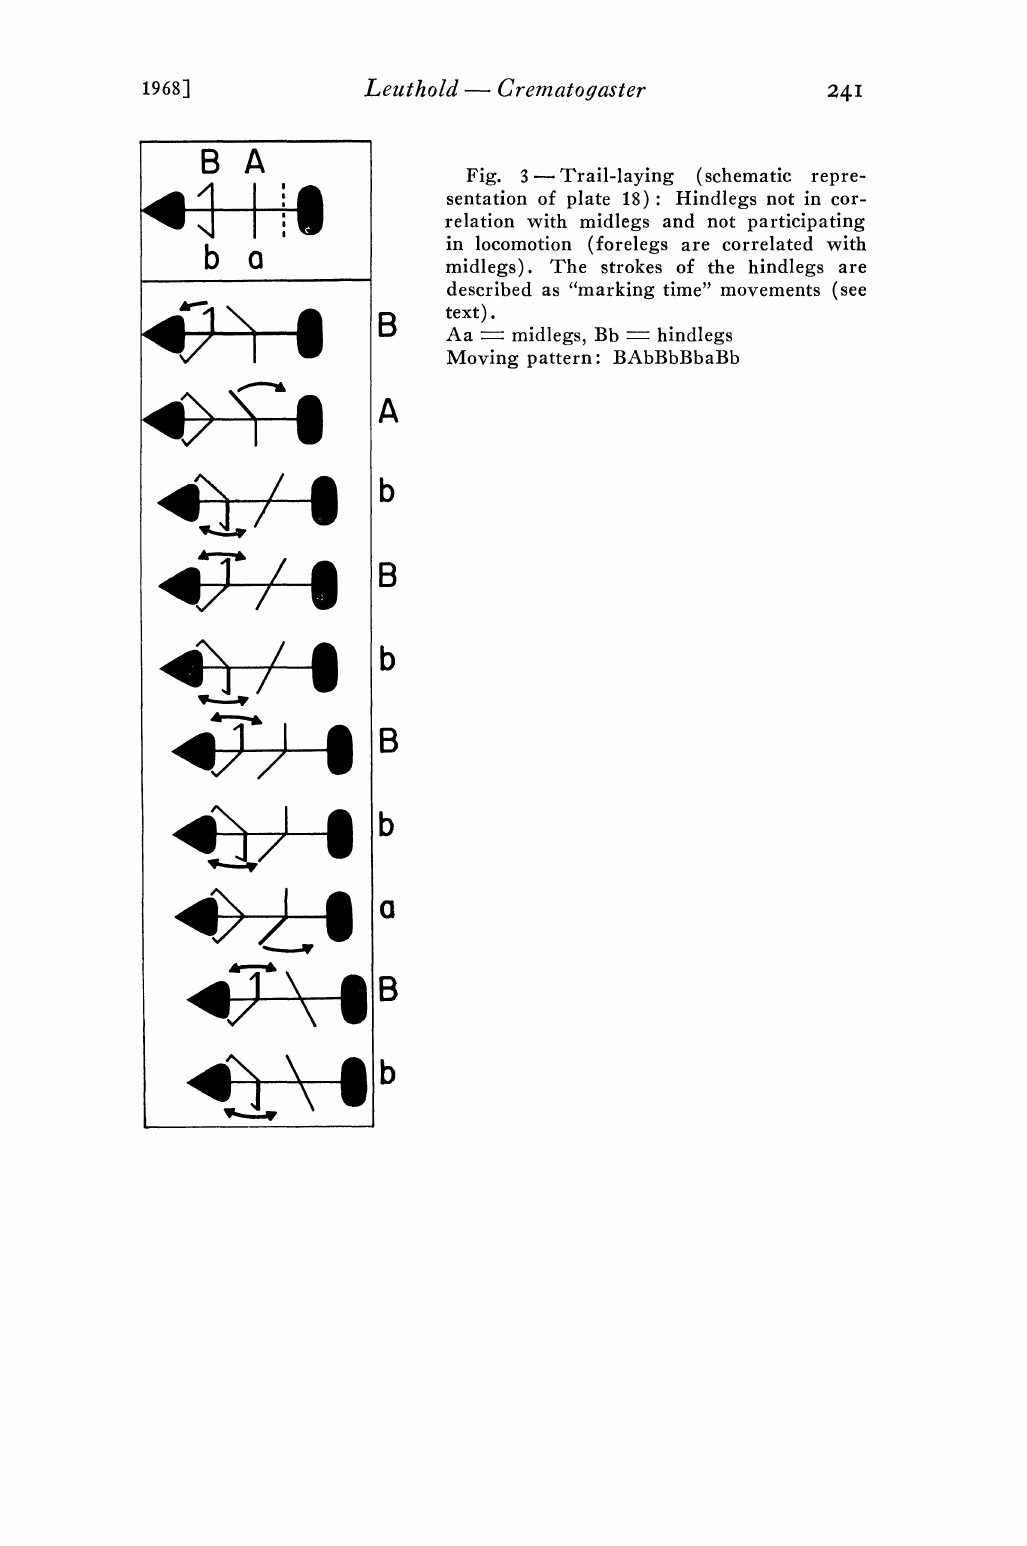
Fig. 3---Trail-laying (schematic repre- sentation of plate 18): Hindlegs not in cor- relation with midlegs and not participating in locomotion (forelegs are correlated with midlegs). The strokes of the hindlegs are described as "marking time" movements (see text). Aa- midlegs, Bb hindlegs Moving pattern"